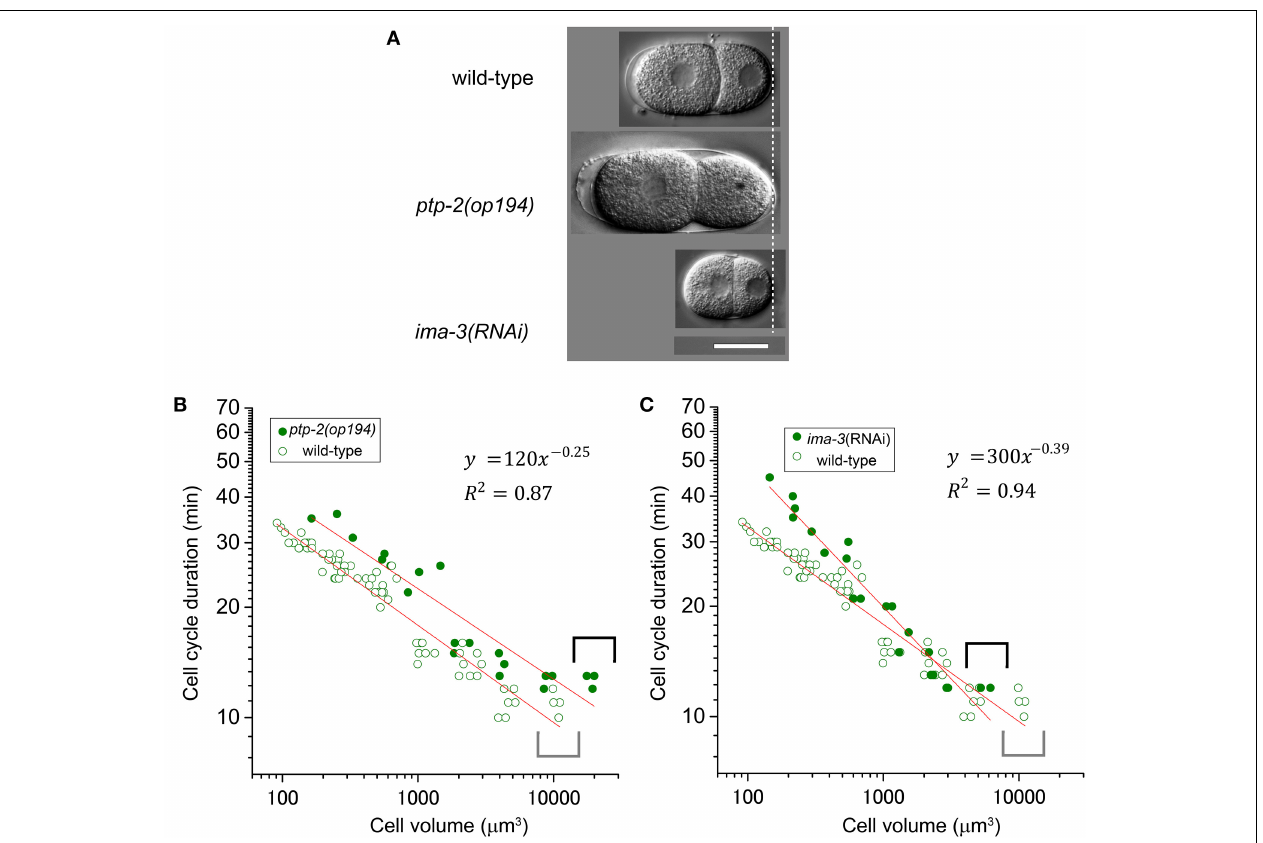
FIGURE 6 | Relationship between cell cycle duration and cell volume in loss-of-function embryos. (A) Images of embryos at the two-cell stage for wild-type, ptp-2(op194) , and ima-3 RNAi embryos were obtained by differential interference contrast (DIC) microscopy. Scale bar = 20 μ m. Relationship between cell cycle duration and cell volume in AB lineage in ptp-2(op194) [filled circles in (B) ] and ima-3 (RNAi) [filled circles in (C) ]